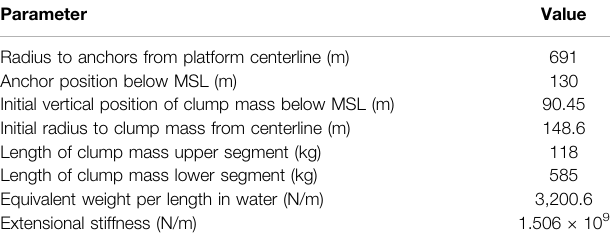
TABLE 3 | The main properties for the mooring system of the 10-MW FWT. Parameter Value Radius to anchors from platform centerline